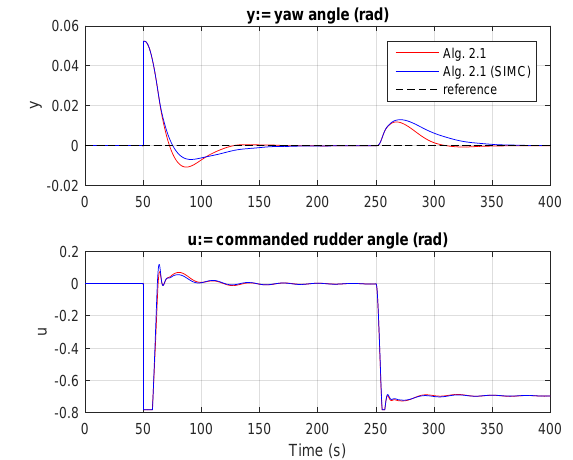
Figure 17: Example 3.9. Simulation of the nonlin- ear Nomoto Vessel model with PID